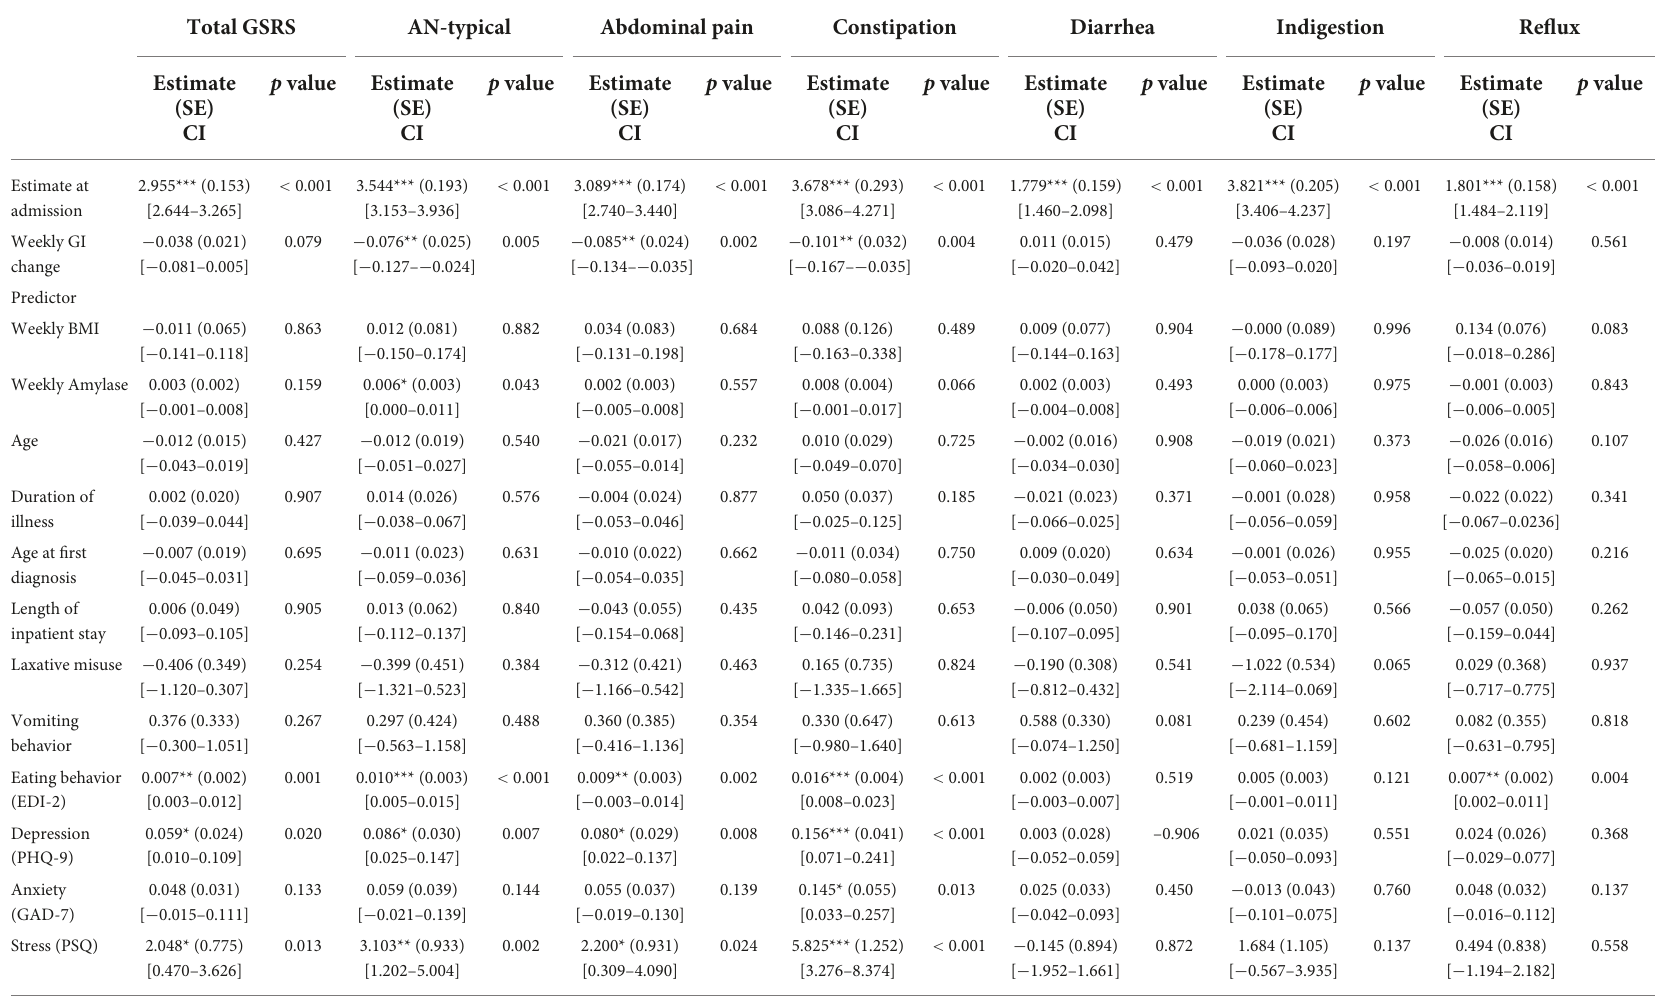
TABLE 2 Key findings of mixed linear models for gastrointestinal symptoms rating scale total and